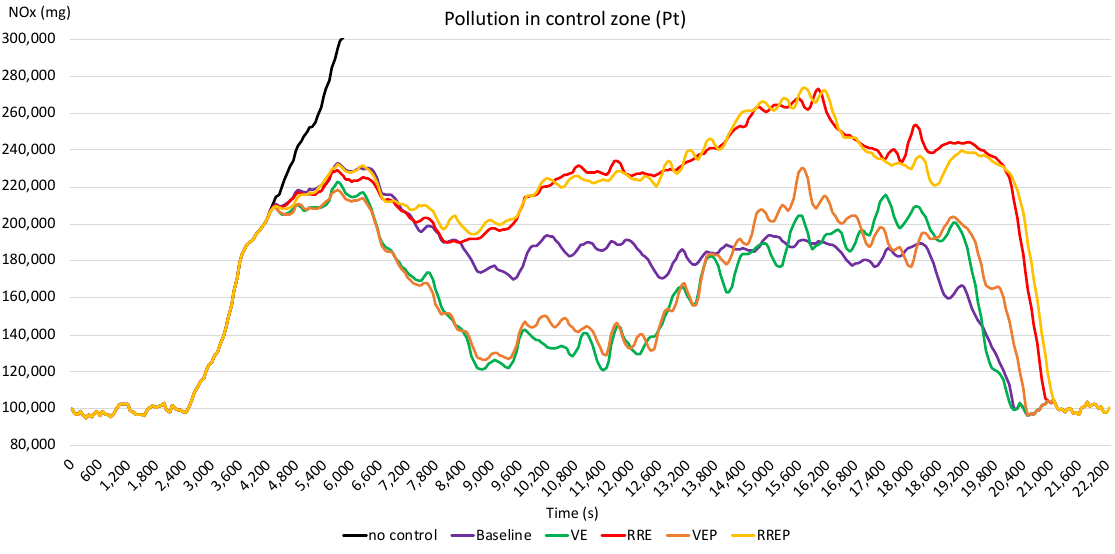
Figure 5. Evolution of the pollution (NO x ) in the control zone during the simulation of pollution- based access with varying arrival rates.